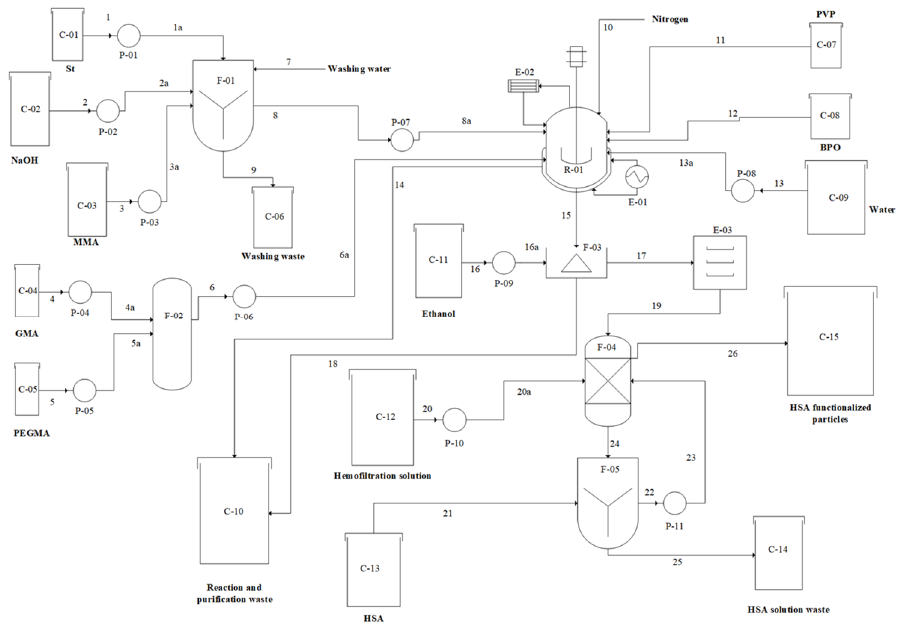
Figure 6. Process Flow Diagram for the industrial synthesis of St-MMA-GMA-PEGMA particles with